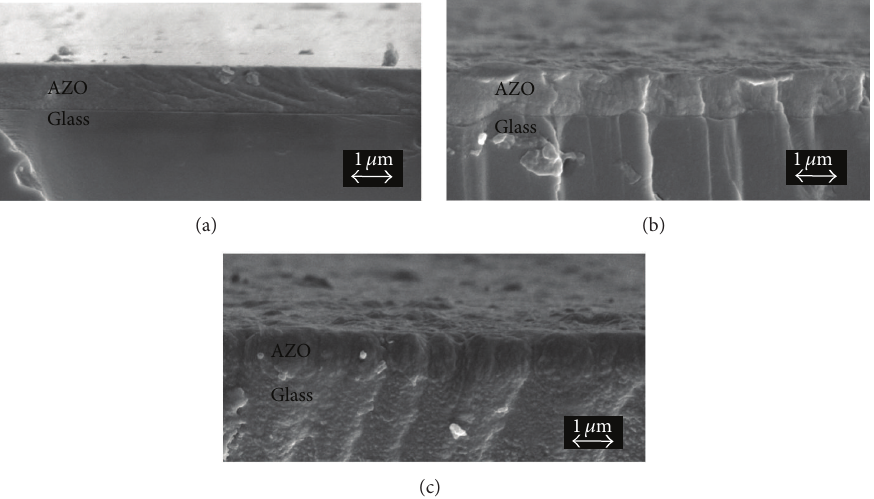
Figure 6: Cross-sectional SEM micrographs of AZO3 deposited on (a) smooth glass, (b) texture E, and (c) texture